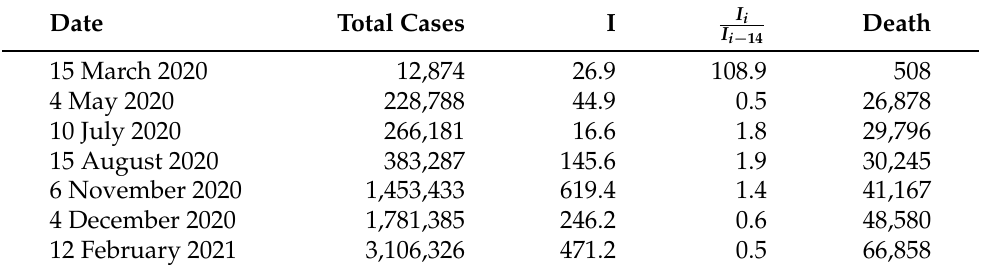
Table 11. Data for Spain: Total cases, Cases per 100,000 inhabitants in the last 14 days, rate of Cases in the last 14 days and the previous 14 days interval, Death related to COVID-19.